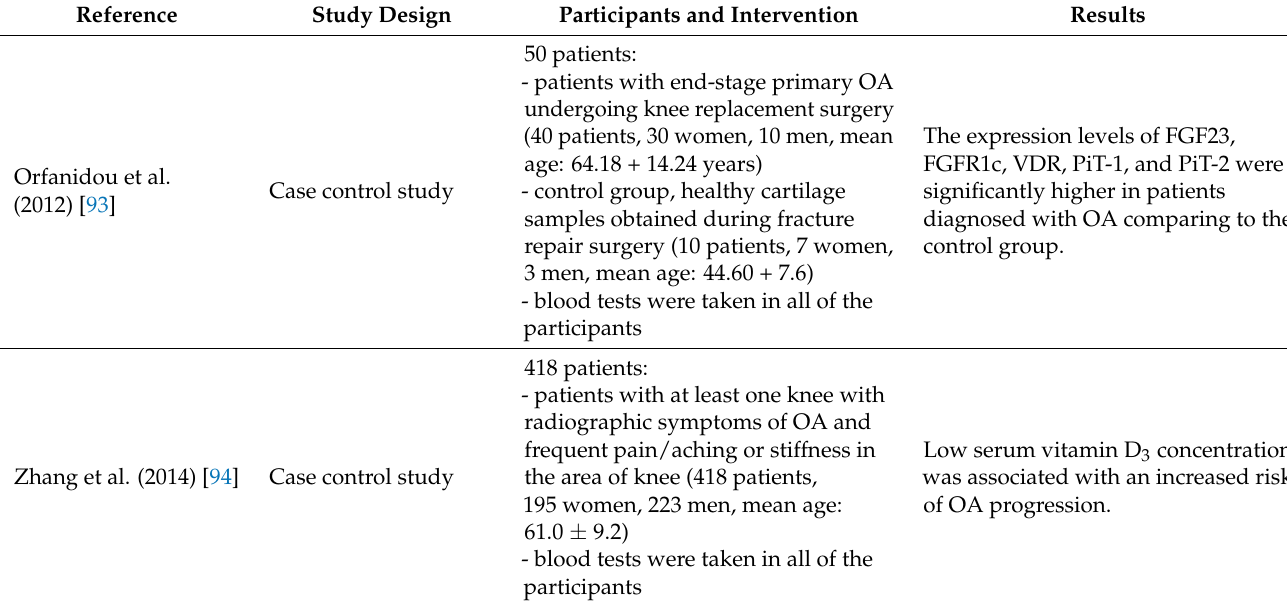
Table 2. The relationship between vitamin D 3 and OA on the basis of the literature